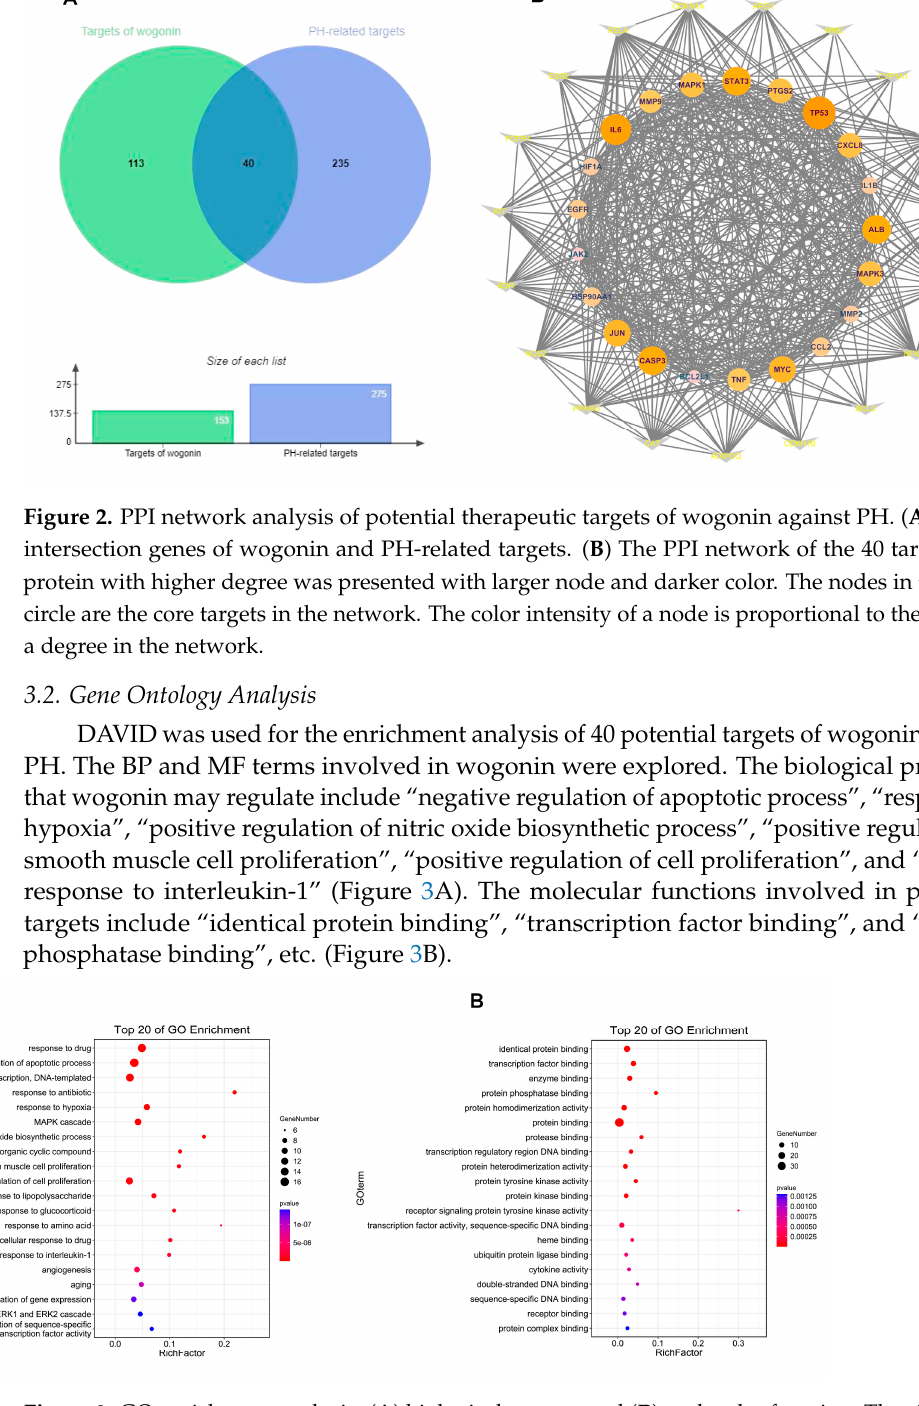
Figure 3. GO enrichment analysis. ( A ) biological process and ( B ) molecular function. The size of the dots indicated the number of enriched targets, and the color of the dots represented the degree of significance based on the p